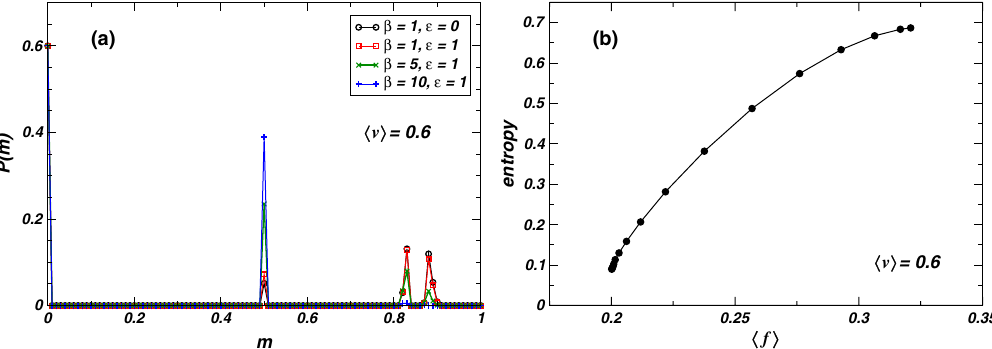
FIG. 10. (a) Distribution P ð m Þ of the probability m that a node is infected in the stationary state of the SIS process on random regular graphs of degree K ¼ 4 , q ¼ 0 . 1 , p ¼ 0 . 5 , h v i ¼ 0 . 6 , and different values of β and ϵ . (b) Entropy of immunization sets of density h v i ¼ 0 . 6 as a function of h f i (obtained by increasing β for ϵ ¼ 1 ).